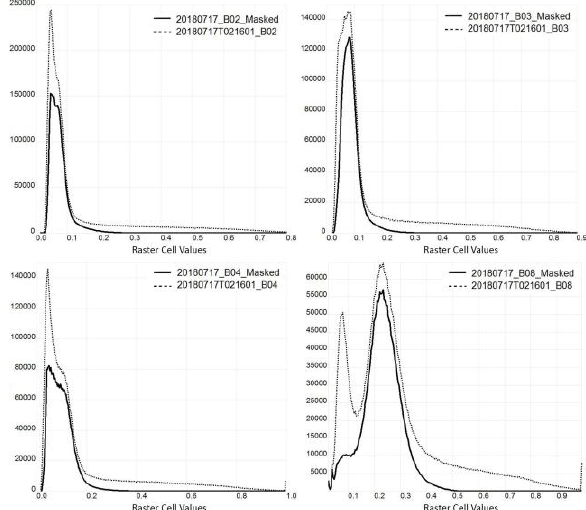
Figure 10. Histograms of reflectance values at each band for a squared sample of 20 km along the image taken at July 17, 2018. Frequency distribution is given for the original image (dot line), and the image after masking (solid line). From top left, to bottom right image: Blue, Green, Red, and NIR band Although here we roughly estimate the effectiveness of the algorithm in terms of clouds/shadows masking, it has been already widely explored. Indeed, a deep analysis is provided by Colaninno et al. (2019), where the M2CTool is systematically compared with the FMask algorithm (Zhu et al., 2015). The FMask is a widely recognized algorithm, which shows the best overall accuracy among many other algorithms they have tested (Foga et al.,